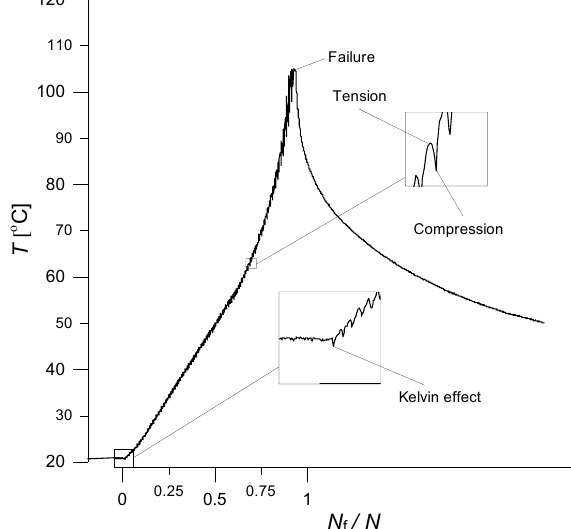
Figure 6. Evolution of temperature over the course of the process of cyclic deformation of a flat sample ENAW 2024T3.